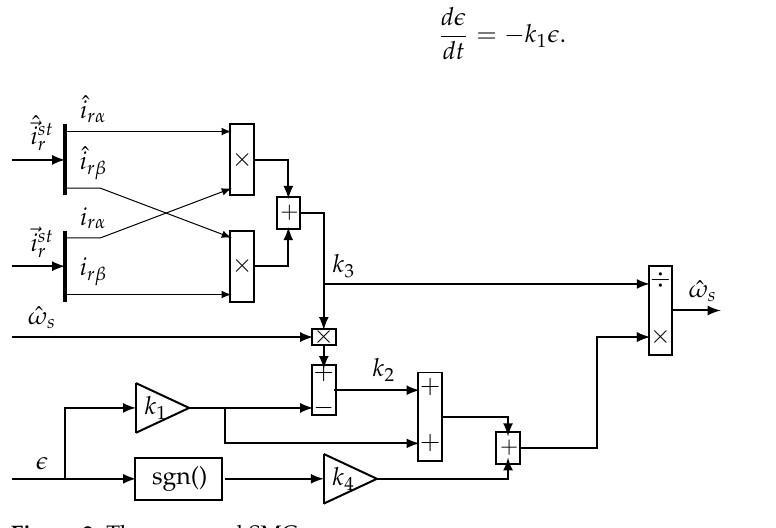
Figure 3. The proposed